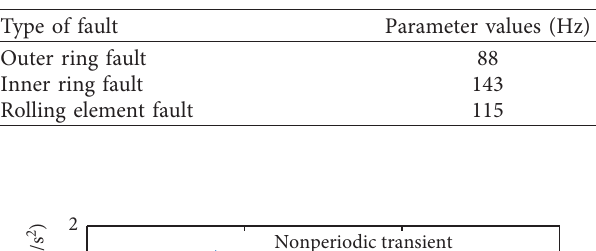
Figure 9: Bearing fault experimental equipment of CWRU. Table 3: Theoretical fault characteristic frequency of bearings.